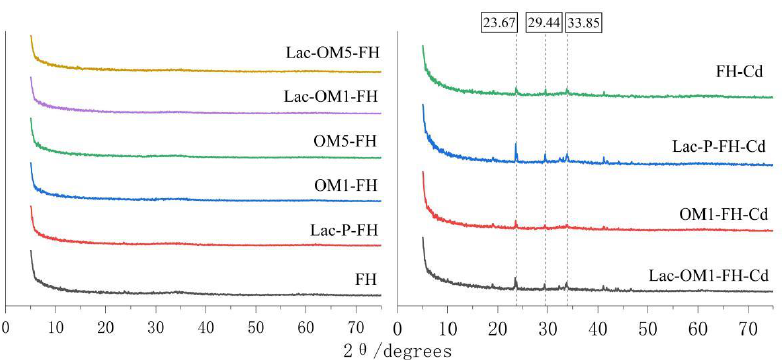
Figure 7. XRD patterns of FH and Fe-OM associations before and after cadmium adsorption. SEM-EDS images (Figure 8) show that the FH and Fe-OM still have no apparent crys- talline morphology after the adsorption of Cd. The EDS mapping results show that the Fe formly distributed in the associations.